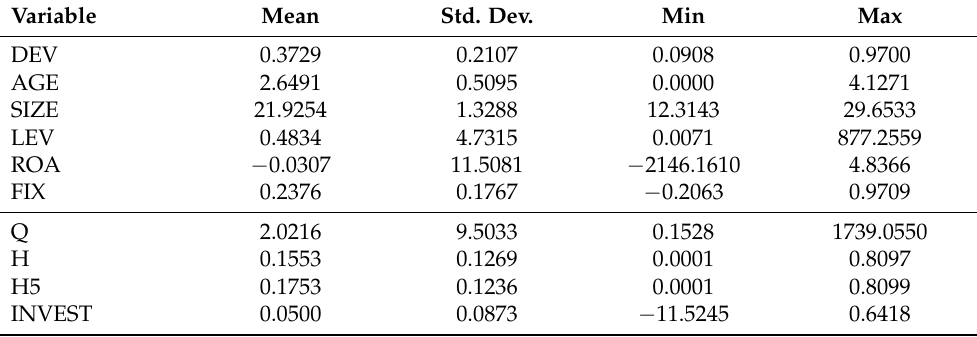
Table 4. Descriptive